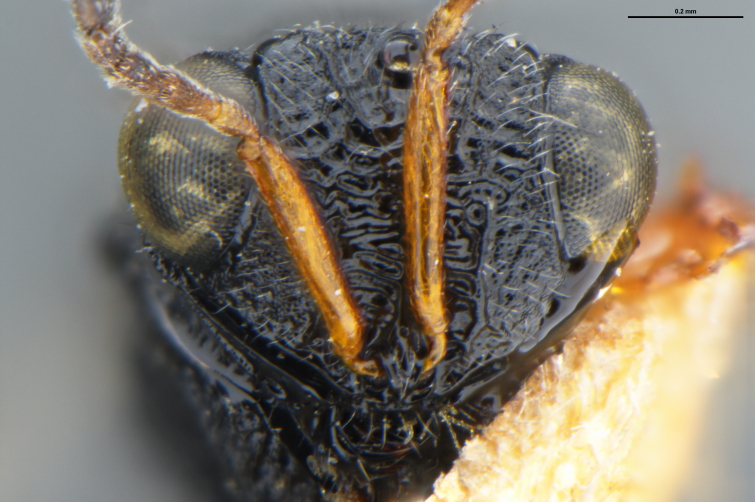
head, anterior view